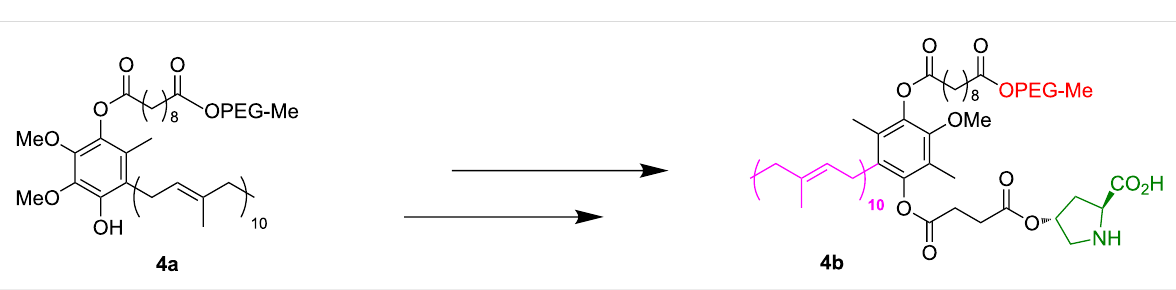
achieved was higher than the ones in organic media.